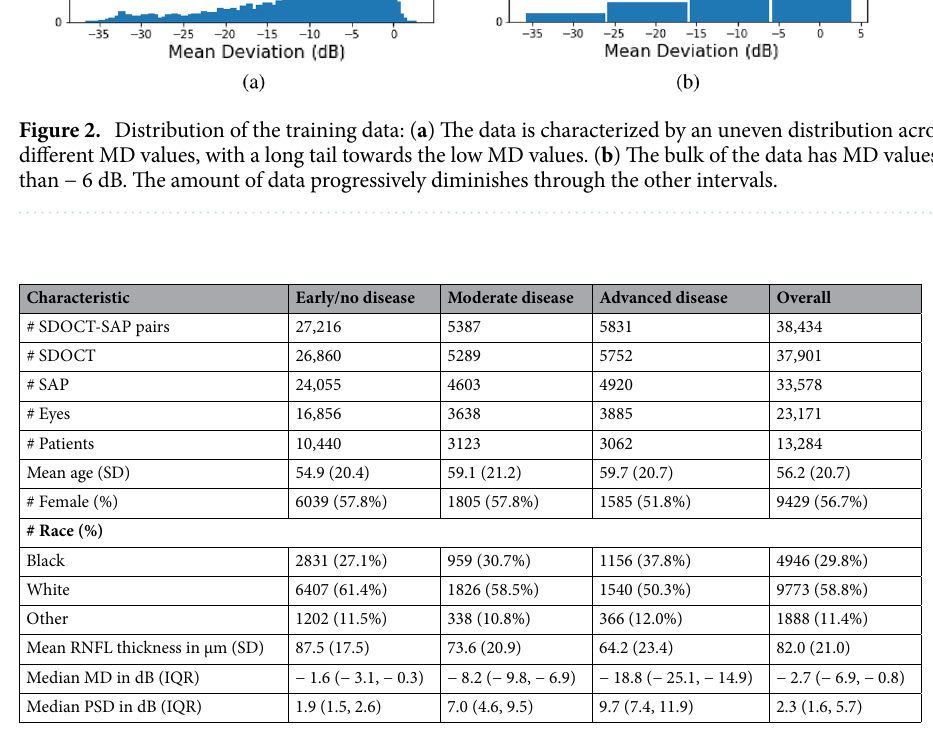
Table 1. Demographic and clinical characteristics of the data. SD: standard deviation; IQR: inter-quartile